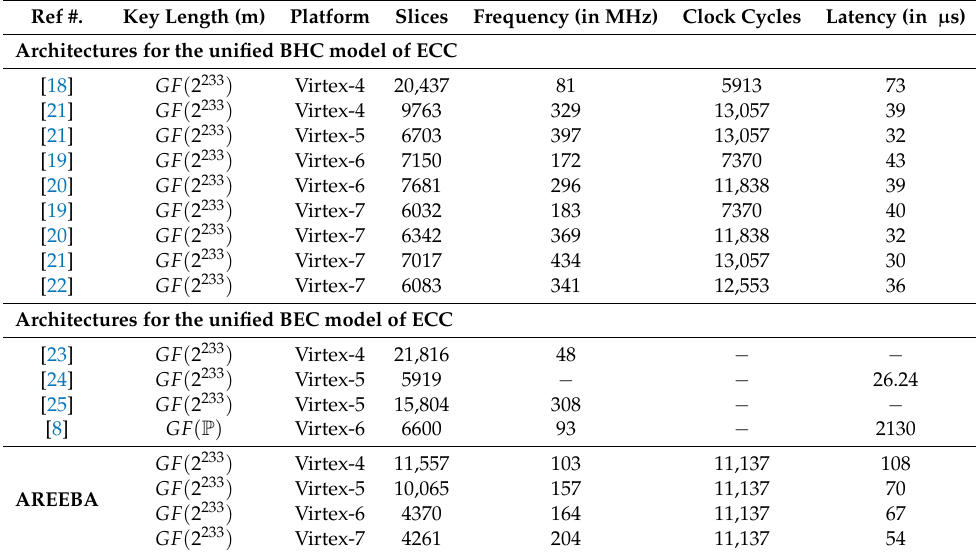
Table 5. Comparison with state of the art architectures over Unif _ Add _ Law computations for PM. Ref